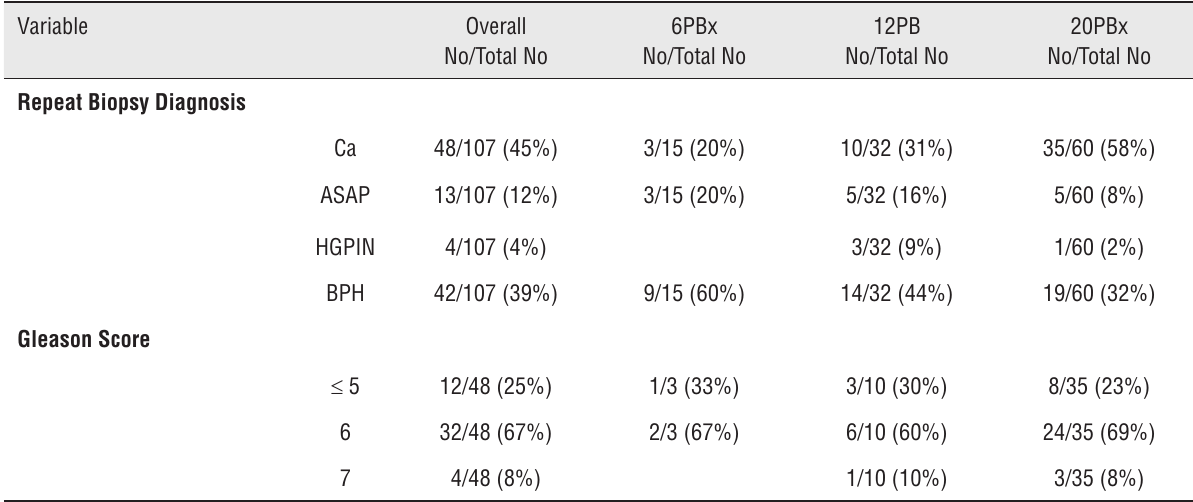
Table 3 - Pathological findings at repeat prostate biopsy for ASAP. Variable